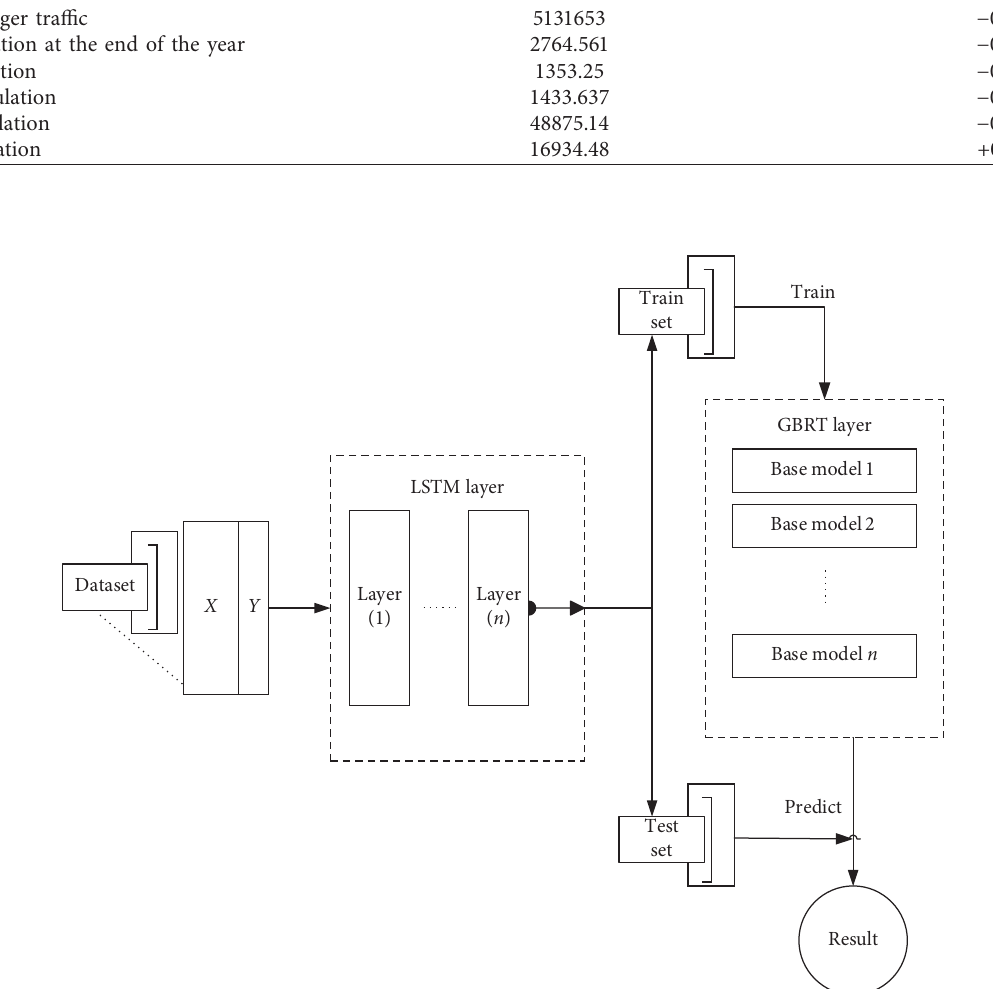
Figure 3: The structure of the LSTM-GBRT